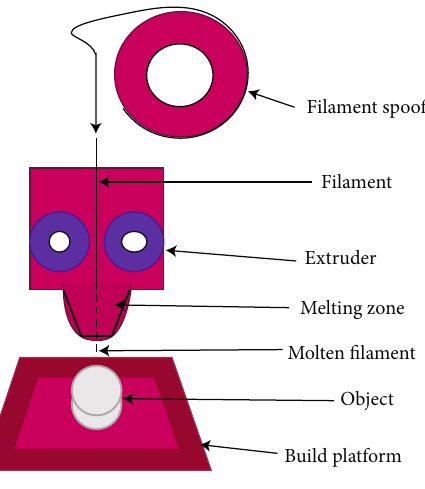
Figure 4: Material extrusion process (software: draw.io-online free